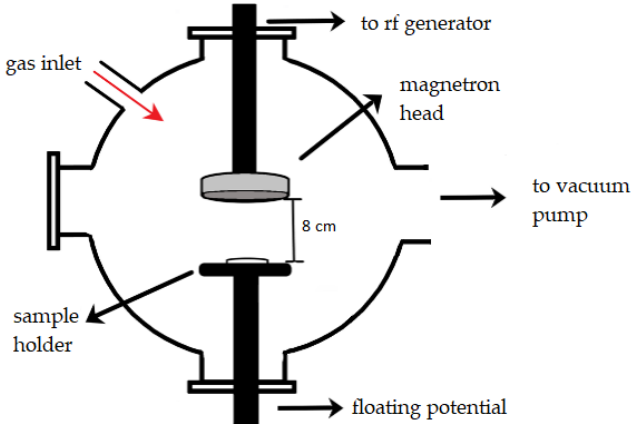
Figure 1. Experimental set-up.